Question: What visual encoding does this figure use to show its data?
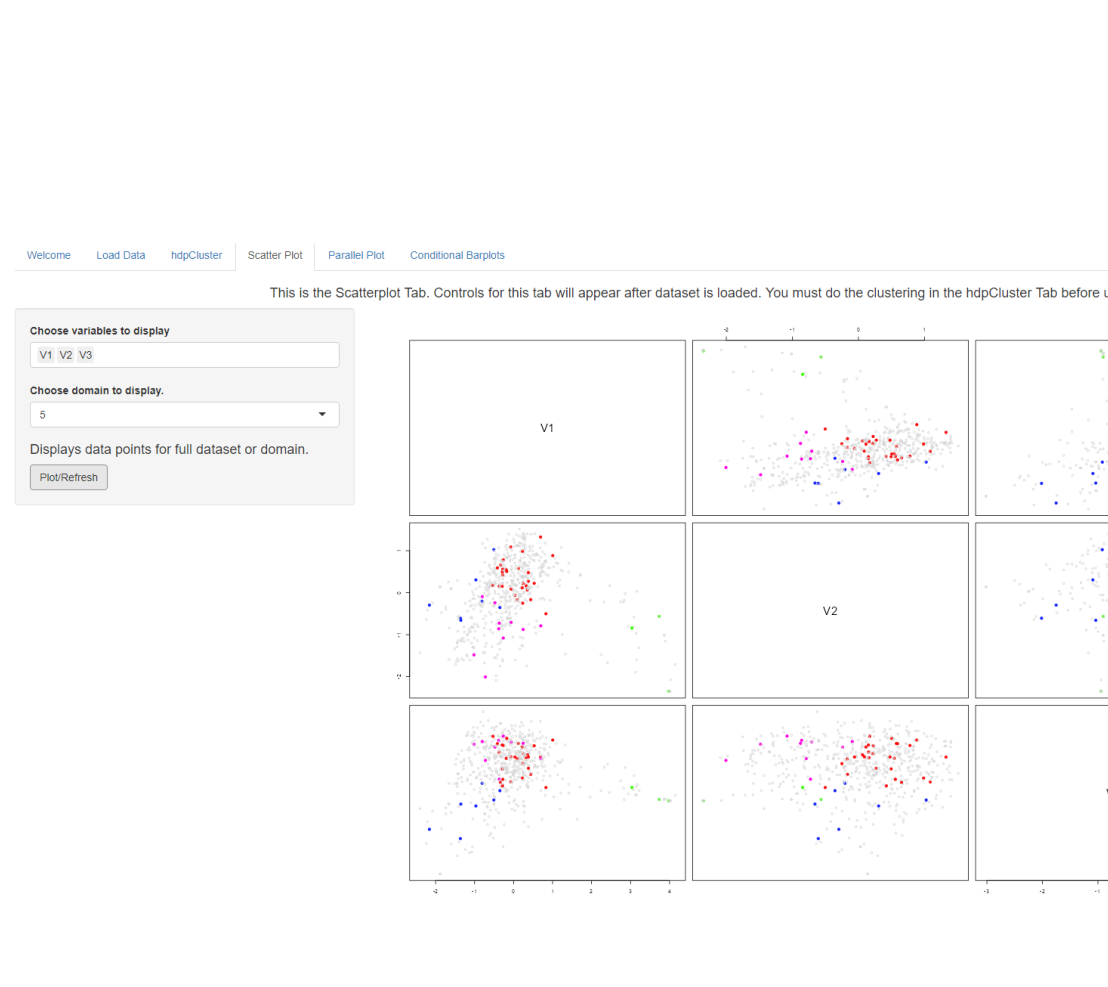
Answer: scatter